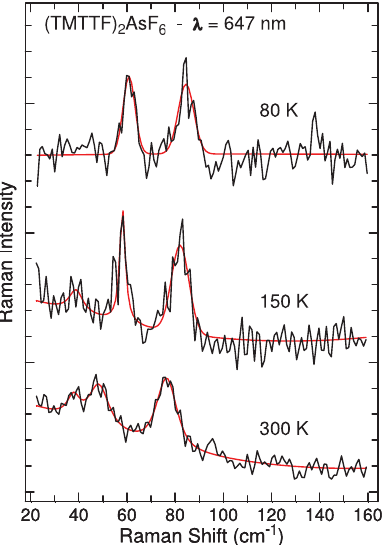
Figure 28. Unpolarized resonant Raman spectra of (TMTTF) temperature taken with λ = 647